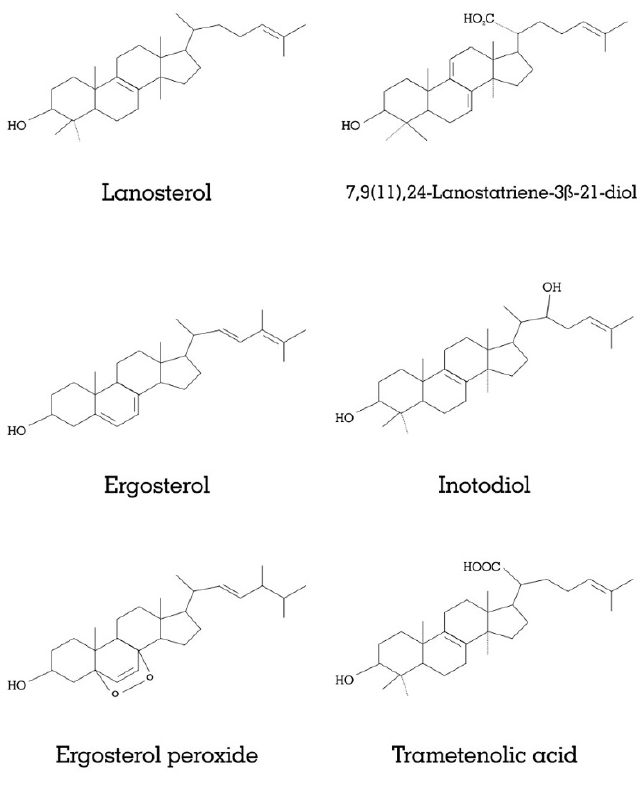
Figure 1. Active phytochemicals derived from mushrooms having the anticancer effect. Edible mushroom Pholiota adiposa showed constituents with antioxidant and anti-HIV activities [46]. The compound HEB showed antioxidant potency, DPPH radical activity. The compound could show the inhibition of HIV-1 replication in the TZM-BL cells infected by the pseudovirus. The compound showed the inhibition of the viral entry process and enzymes required to enter the HIV-1 life cycle. The HEB showed inhibition of reverse transcriptase and integrase activities, which was high compared to pepstatin A. Many other researchers also reported anti-HIV action of mushrooms and their constituents, as shown in Table